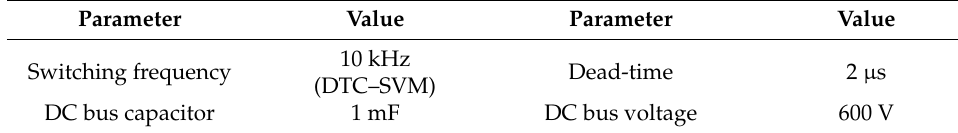
Table 4. Parameters of the Inverter.